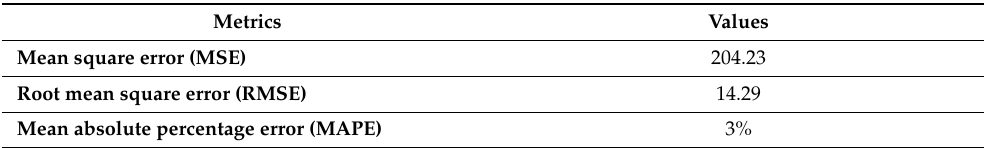
Table 2. Error metric analysis using the MSE, RMSE, and MAPE. Metrics Values Mean square error (MSE)